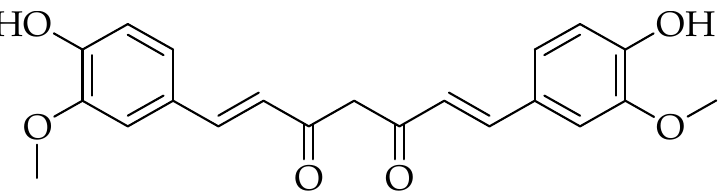
Figure 1. The chemical structure of curcumin.